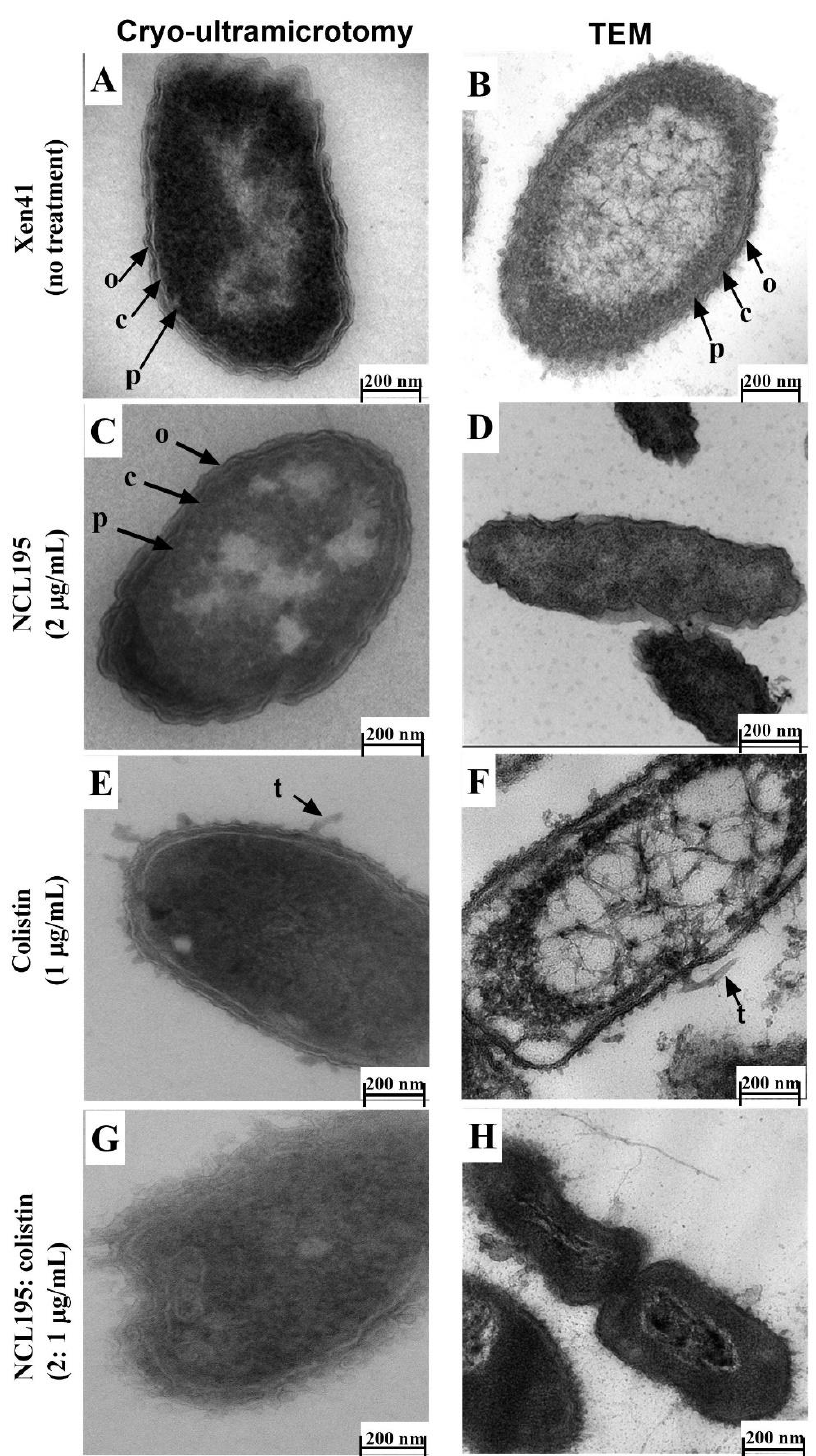
Figure 8. Comparison of Xen41 cells with or without antibiotic treatment and processed by Tokuyasu cryo-ultramicrotomy vs. conventional TEM. Approximately 5 × 10 8 cells were treated for 1 h. ( A ) vs. ( B ) cells without treatment; ( C ) vs. ( D ) treatment with NCL195 at 2 µg/mL showing clearer delineation of intact outer membrane, cell wall and plasma membrane than TEM images and no effect of NCL195 treatment on cell morphology; ( E ) vs. ( F ), Xen41 cells treated with colistin at 1 µg/mL and ( G ) vs. ( H ) Xen41 cells exposed to a combination of NCL195 at 2 µg/mL and colistin at 1 µg/mL.